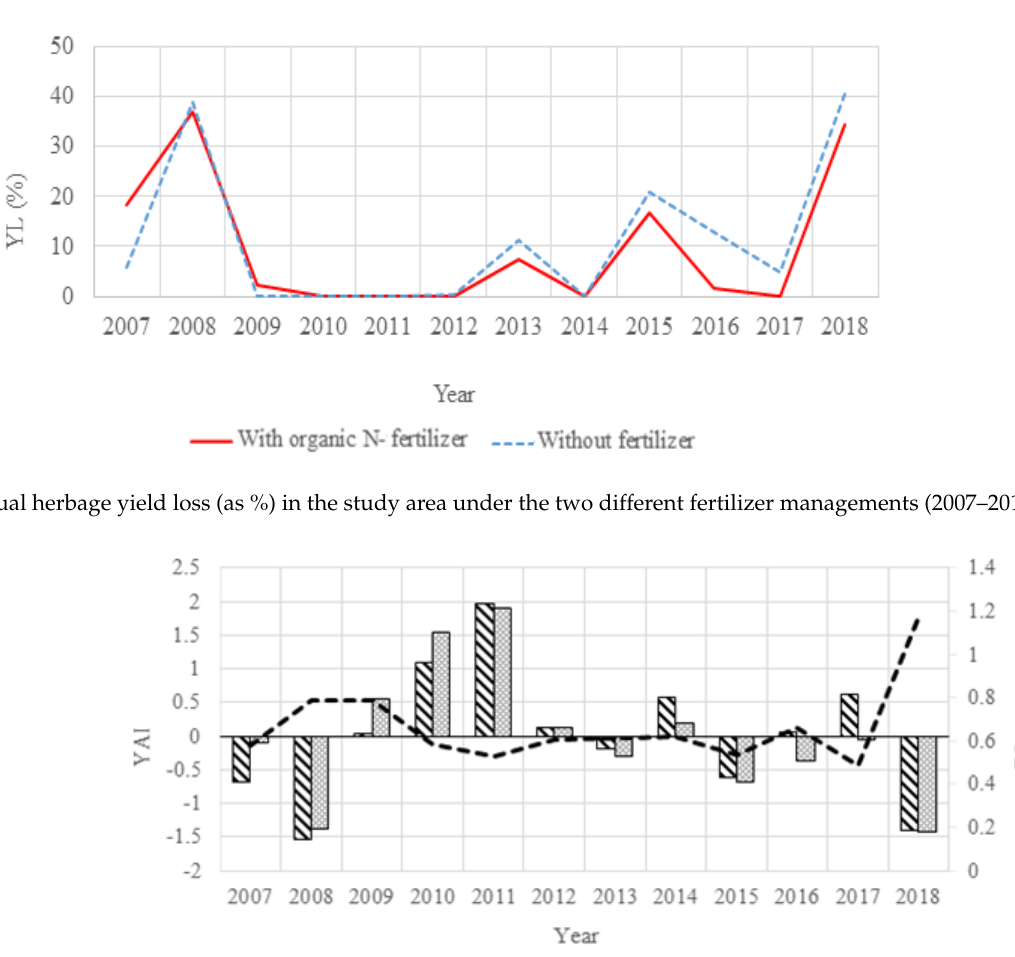
Figure 8. ( a ) Time series of herbage yield and WD for the selected time period (2007–2018). (b) Dry matter (DM) yield values plotted against WD index. The lines denote a regression analysis. A significant relationship (* p ˂ 0.05) is shown between WD and herbage yield with regard to the fertilizer management. ns = not significant.